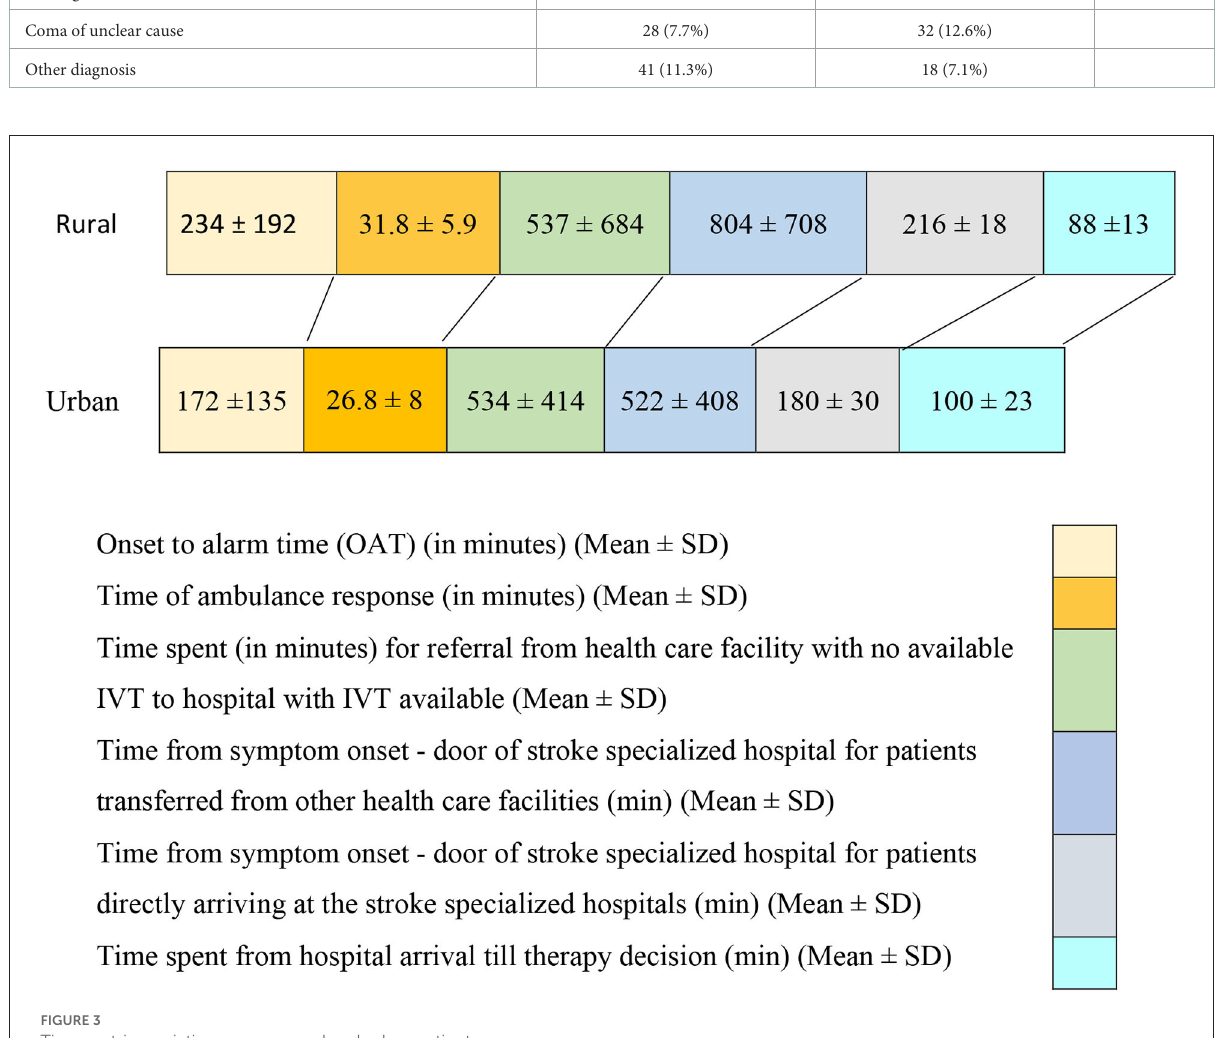
FIGURE3 Time metrics variations among rural and urban patients.